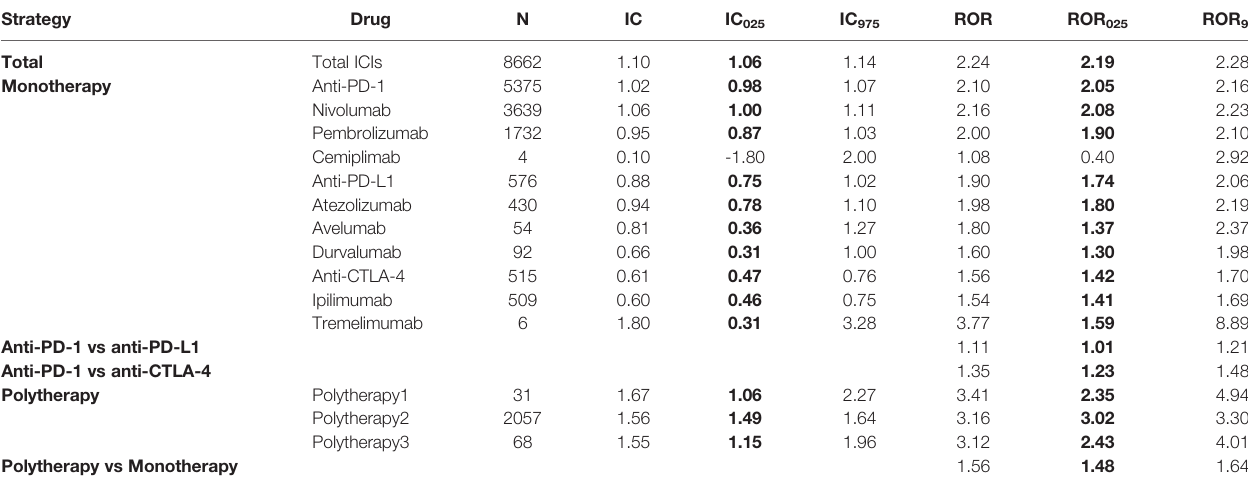
TABLE 2 | Disproportionality by immunotherapy regimens*. Strategy